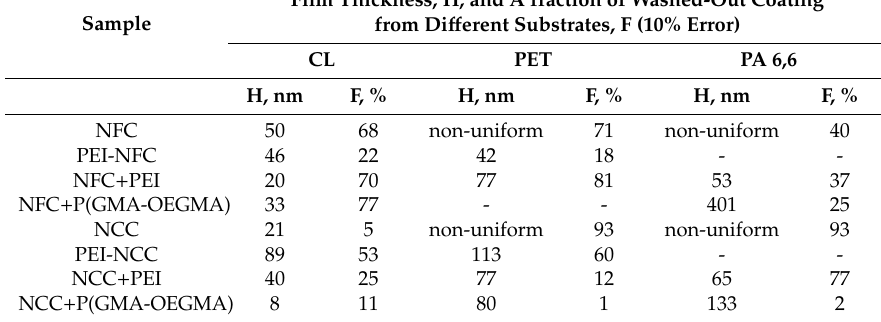
Table 1. Changes in thickness (surface coverage) of nanofibrillated cellulose (NFC) and nanocrystalline cellulose (NCC) coatings on the surfaces of cellulose (CL), poly(ethylene terephthalate) (PET), and nylon 6,6 (PA 6,6) after rinsing in water. PEI, poly(ethylene imine); P(GMA-OEGMA), copolymer of